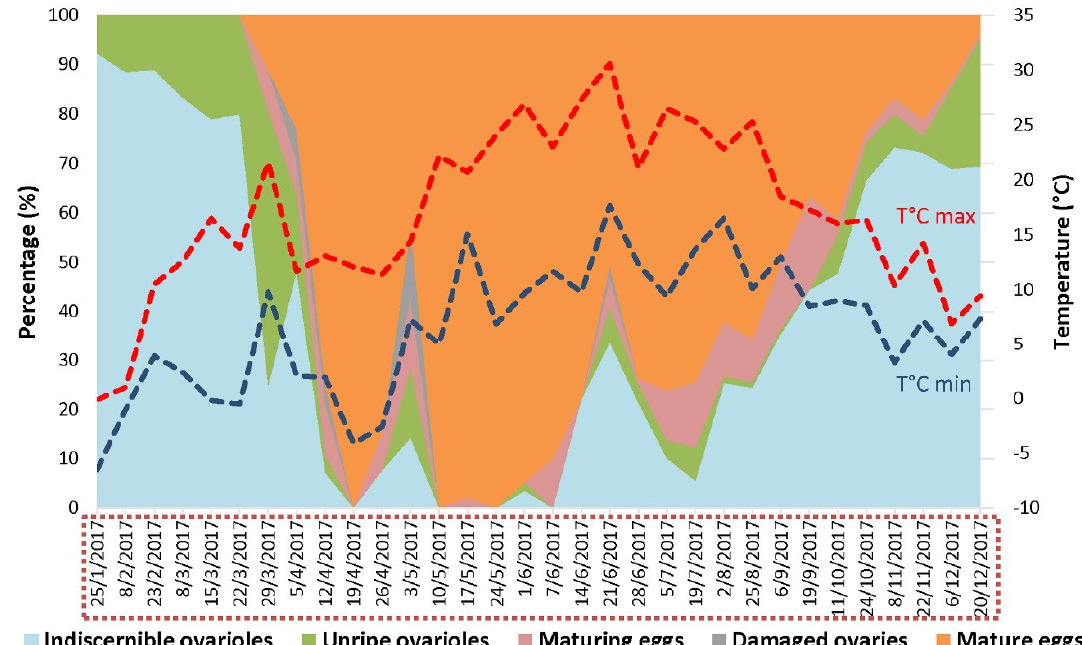
Figure 6. Seasonal reproductive status of dissected D. suzukii females captured in the field from January to December 2017. Reproductive biology is represented together with the minimum (blue dotted line) and maximum (red dotted line) daily temperatures in °C in the study area, The Netherlands. The red dotted rectangle around the dates refers to the period during which field-captured D. suzukii individuals were also assessed for their phenotype (see Figure 7).